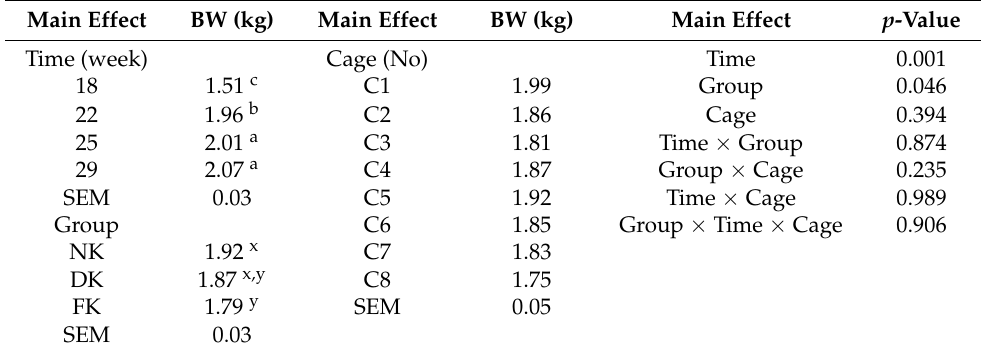
Table 2. Bodyweight changes of laying hens with age in three groups.